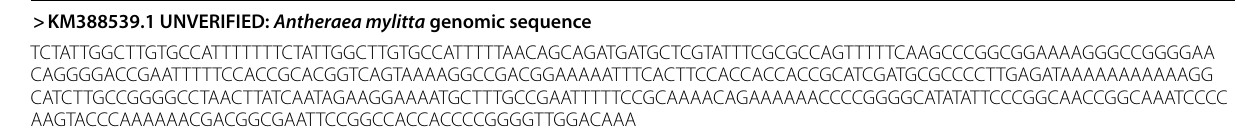
Table 4 Antheraea mylitta cocoonase (AmCoc) nucleotide sequence deposited in NCBI > KM388539.1 UNVERIFIED: Antheraea mylitta genomic